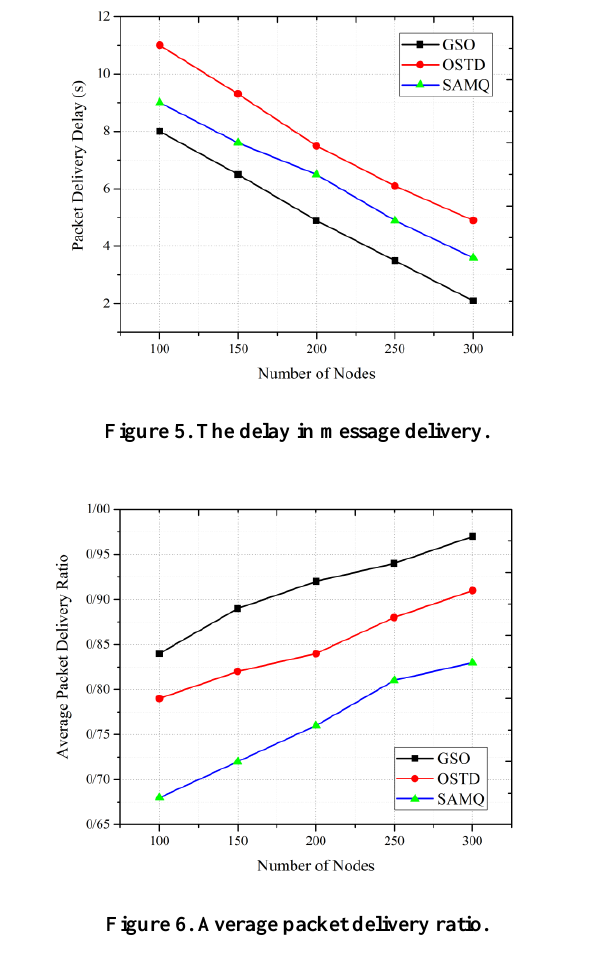
Figure 6. Average packet delivery ratio.